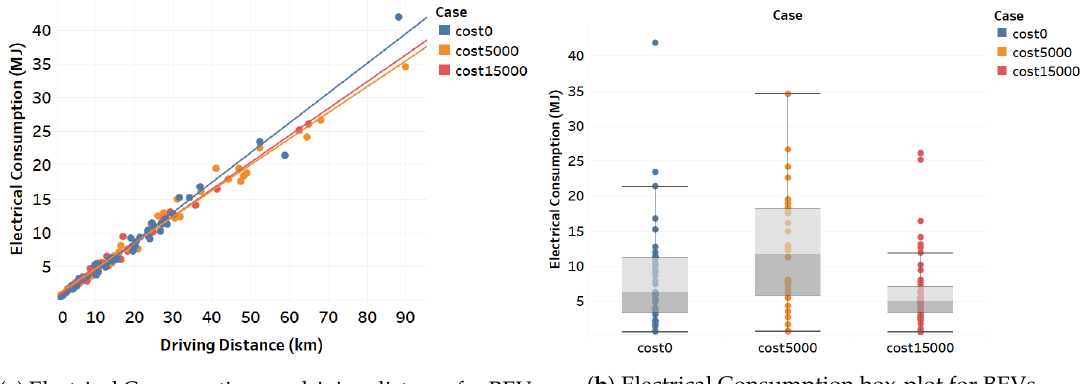
Figure 8. Electrical Consumption distribution for BEVs.